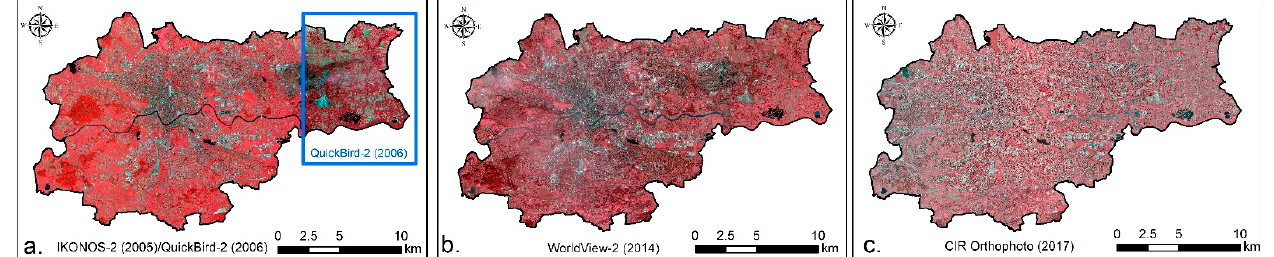
Figure 2. Krakow in false-color imagery using the near infrared (NIR), red, and green spectral bands—this image shows vegetation in a red tone, as vegetation reflects most light in the NIR; ( a ) IKONOS-2 (2005) and QuickBird-2 (2006); ( b ) WorldView-2 (2014); and ( c ) CIR aerial orthophoto (2017).